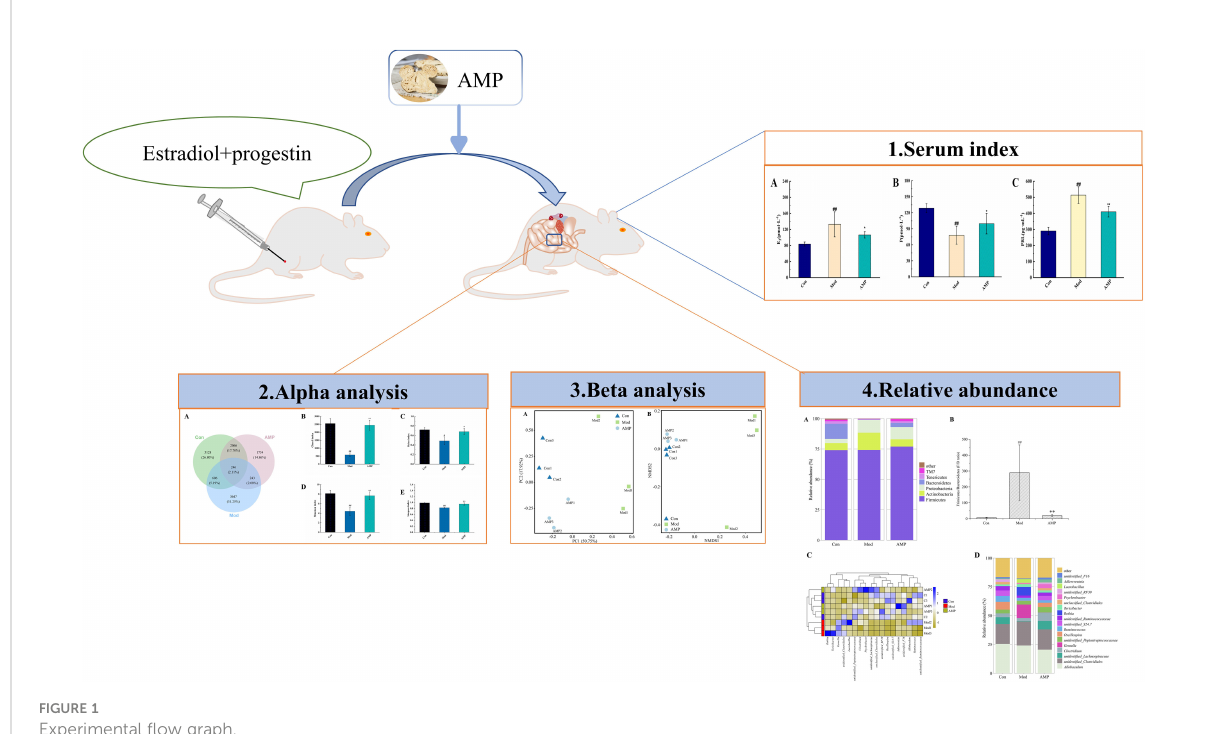
FIGURE 1 Experimental fl ow